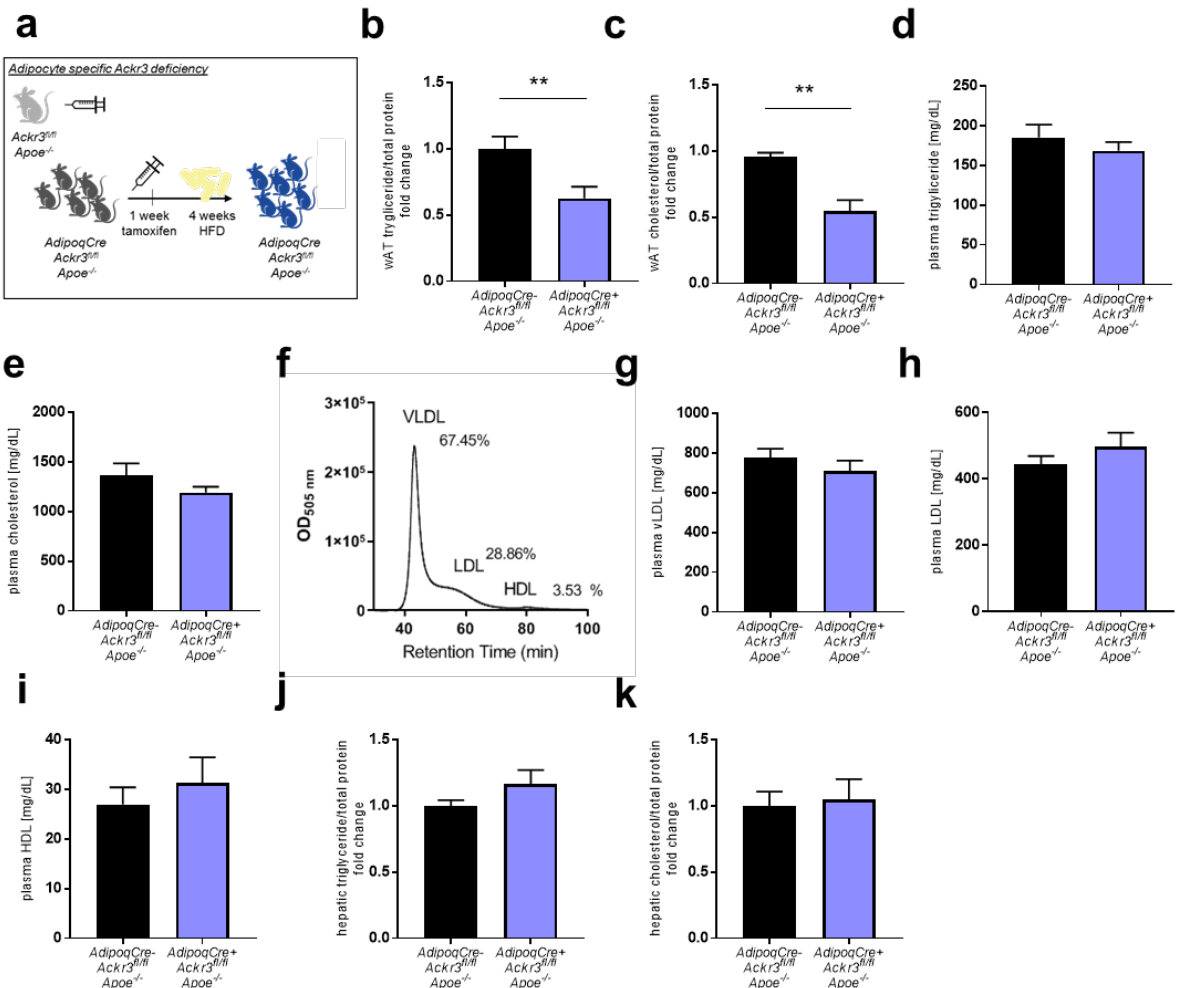
Figure 1. Atypical chemokine receptor 3 (ACKR3) deficiency reduces adipose tissue lipid levels. ( a ). Schematic representa- tion of the experimental setup. ( b , c ). Total triglyceride ( b , n = 12–14) and total cholesterol ( c , n = 9–10) content in visceral white adipose tissue (wAT) samples normalized to total protein levels. ( d , e ). Total triglyceride ( d ) and total cholesterol ( e ) levels in the plasma of mice ( n = 13–14). ( f ). Representative HPLC chromatogram of plasma lipoprotein fractions (very-low-density lipoprotein (VLDL), low-density lipoprotein (LDL), and high-density lipoprotein (HDL)). ( g – i ). Plasma levels of VLDL ( g , n = 12–14), LDL ( h , n = 12–14), and HDL ( i , n = 12–14) levels. ( j , k ). Total triglyceride ( j , n = 12–14) and total cholesterol ( k , n = 12–14) levels in liver samples normalized to total protein levels. ** p <